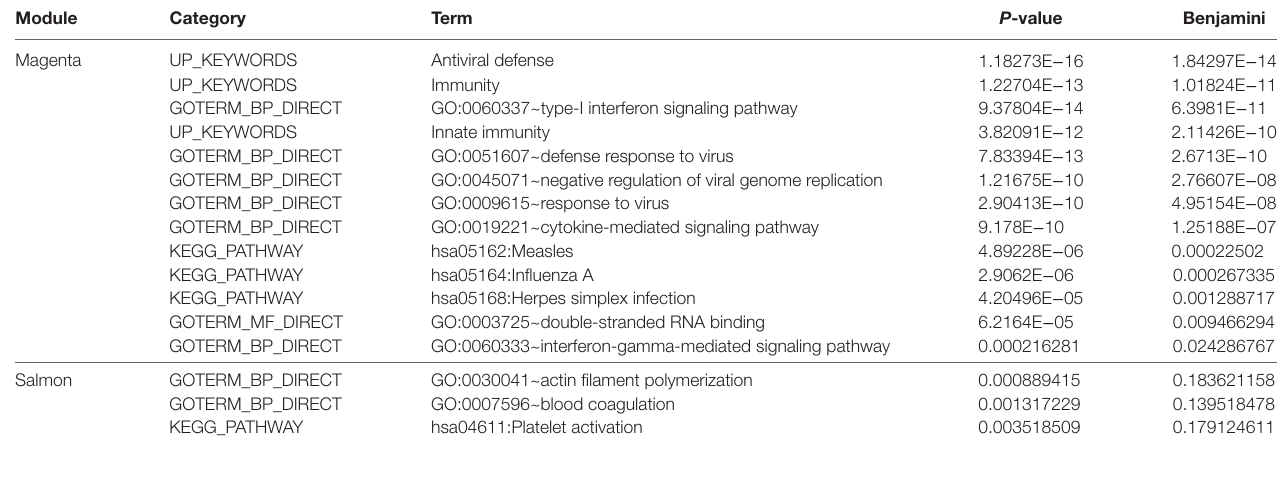
TaBle 1 | Gene ontology and enriched KEGG pathways for “magenta” and “salmon” modules.